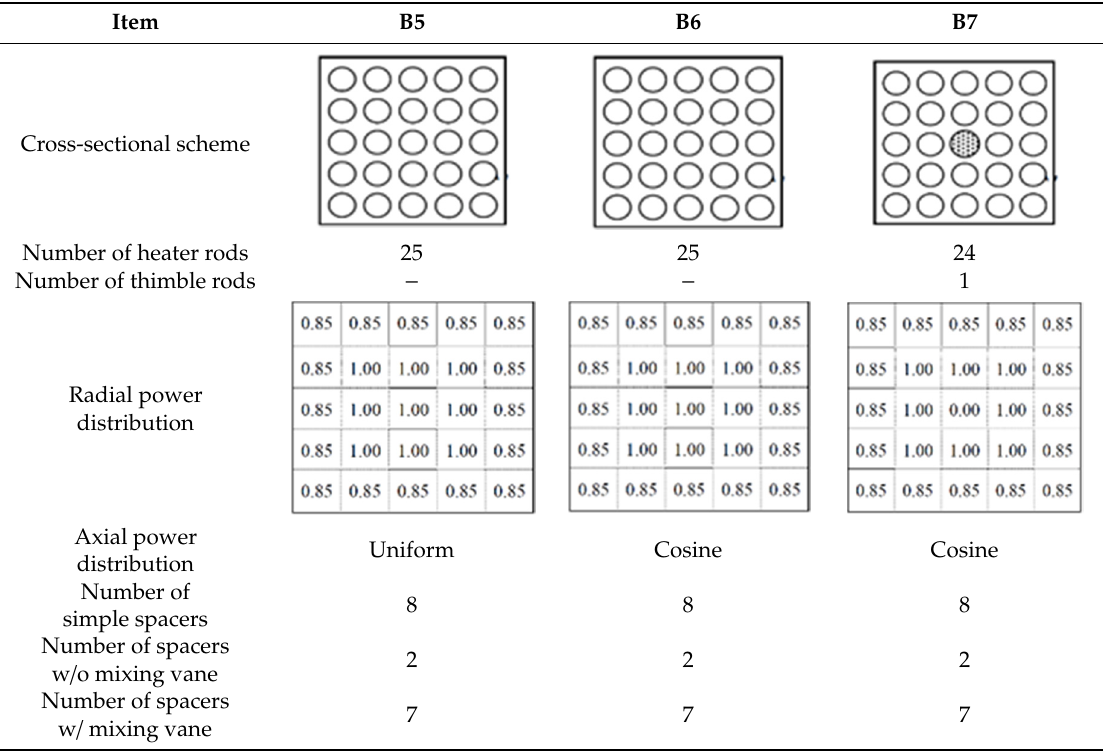
Table 1. Specification of the bundle test section [8].